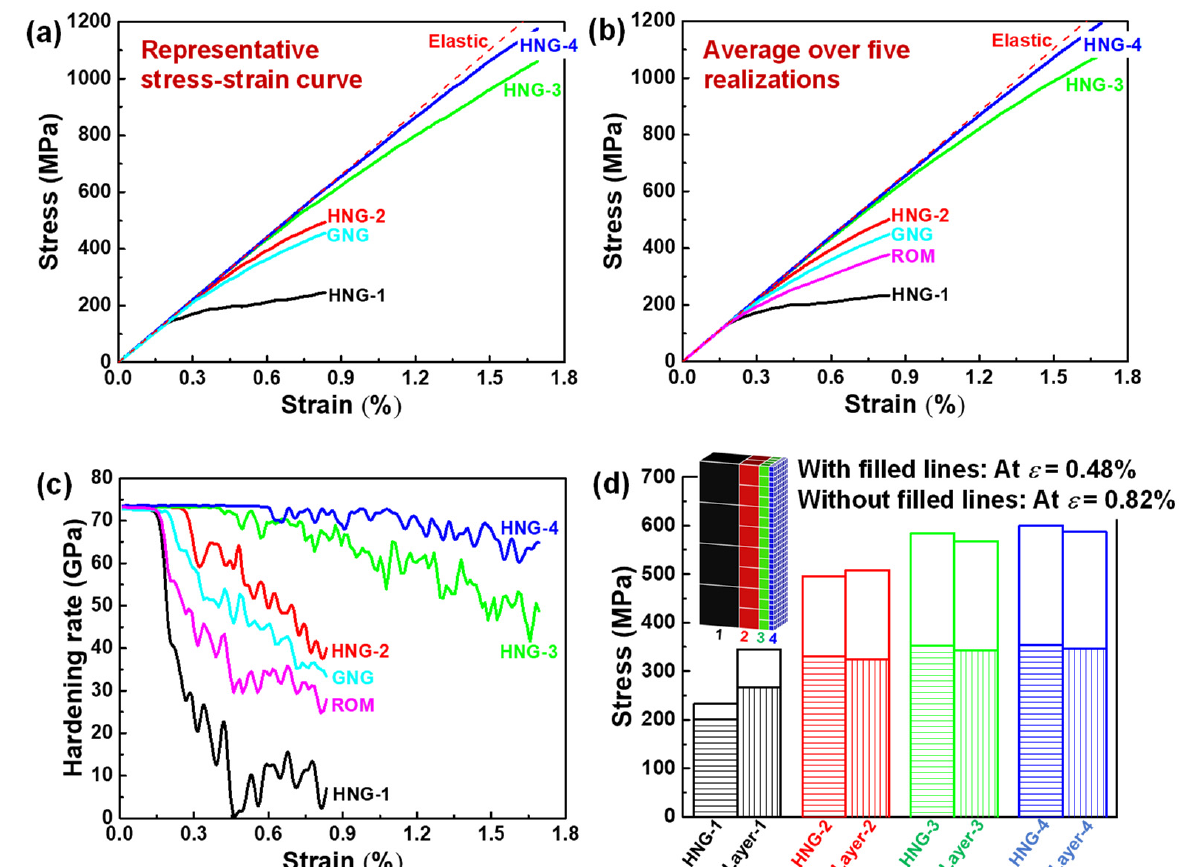
Figure 2. ( a ) Representative stress-strain curves and ( b ) average stress-strain curves (the results are obtained by averaging five realizations) of the GNG sample and four HNG samples. ( c ) The corresponding strain-hardening rate versus strain curves. ( d ) Stress at the strains of 0.48% and 0.82% for four HNG samples and the corresponding four layers in the GNG sample; the insert shows different layers in the GNG sample. The curves calculated from the rule of mixtures (ROM) are also plotted in ( b , c ).